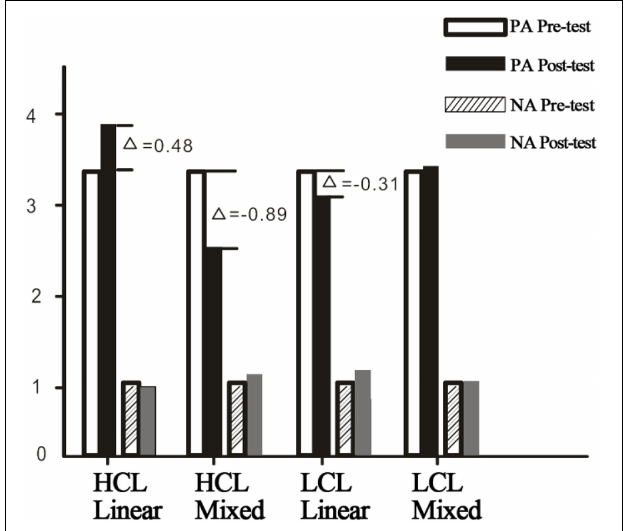
FIGURE 3 | Comparison of affective experience variation.